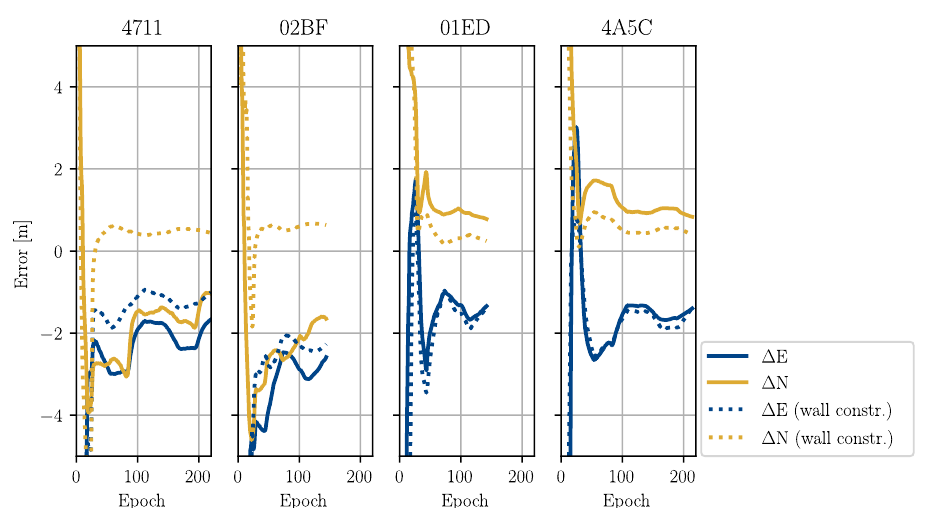
Figure 16. Time series of errors in the anchor position estimates for Case 2, with and without the wall constraint. In each epoch, one range measurement was processed. The number of epochs differs due to the number of available ranges (simulated ranges < 45 m).